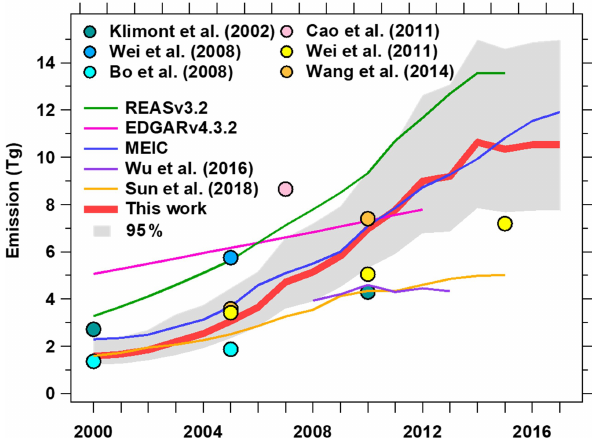
Figure 6. Comparison of NMVOC emissions from solvent use be- tween this study and previous